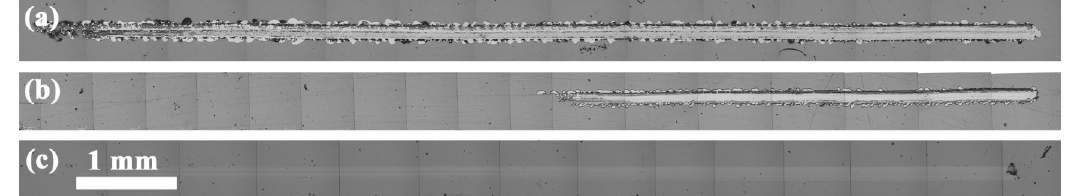
Figure 4. The OM images of the scratch track of (Al 0.34 Cr 0.22 Nb 0.11 Si 0.11 Ti 0.22 ) 50 N 50 coatings on WC/Co substrates with various interlayer: ( a ) Cr interlayer, ( b ) Al 0.34 Cr 0.22 Nb 0.11 Si 0.11 Ti 0.22 interlayer, and ( c ) Ti interlayer. Table 1. Critical loads in scratch test and damage ratings in Rockwell C indentation